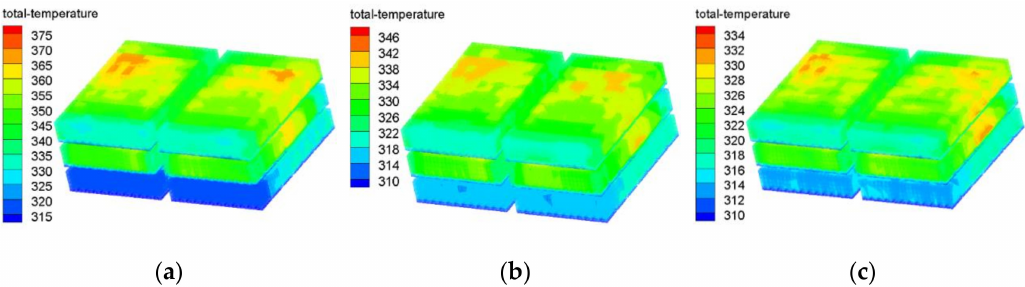
Figure 9. Temperature cloud diagrams for type III battery pack under different inlet wind speeds: